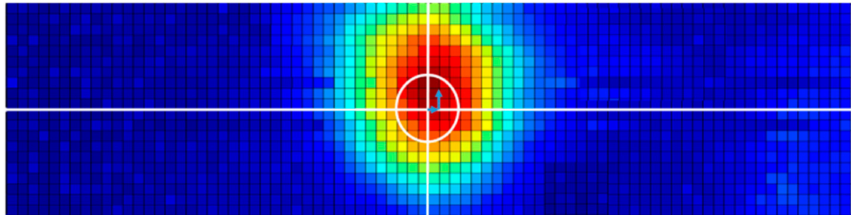
Figure 17. C-scan image of the flat bottom hole in the dissimilar metal weldment specimen.